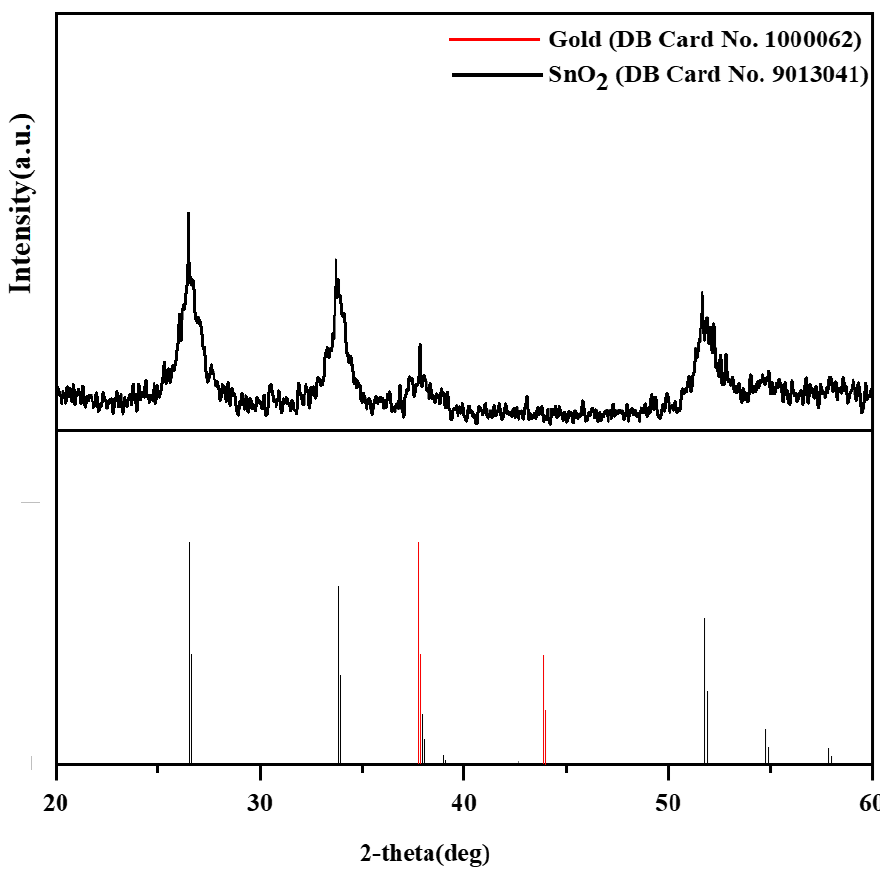
Figure 3. XRD Patterns of Au NPs/SnO 2 NFs composite.